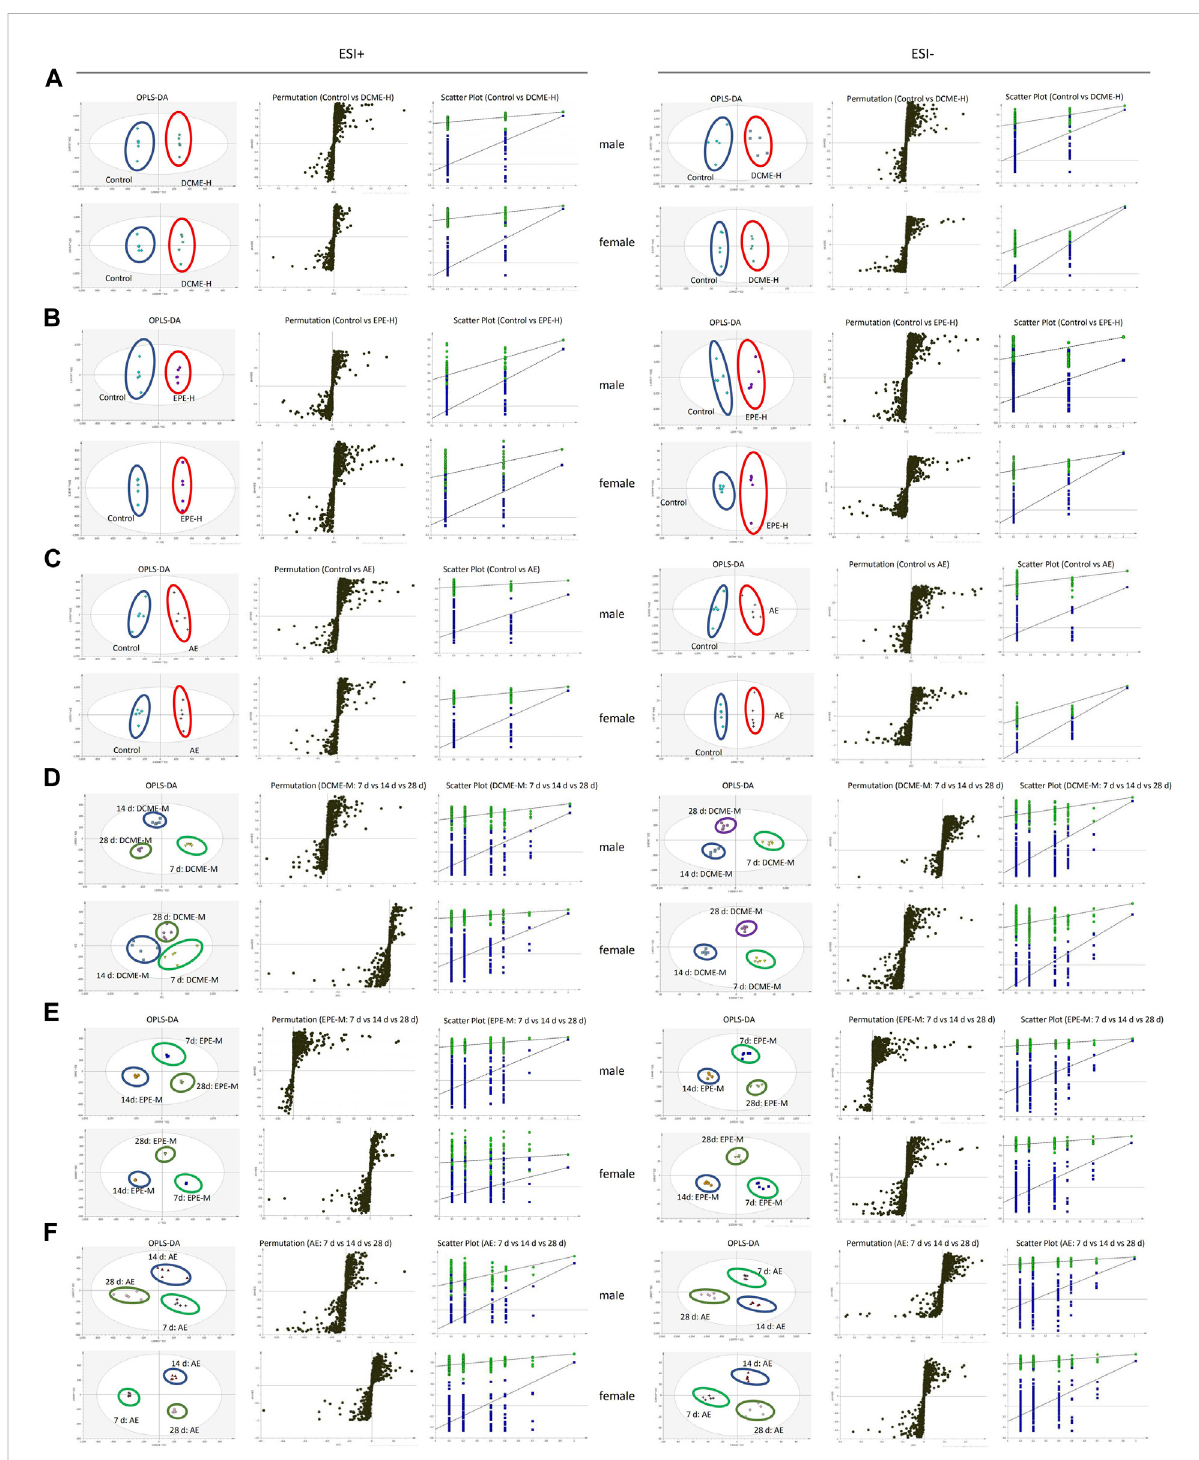
FIGURE 3 The OPLS-DA score plots, S-plots and 200-permutation test in the positive (ESI+) and negative (ESI-) modes. (A) Comparison of DCME-H and Controlgroups. (B) ComparisonofEPE-HandControlgroups. (C) ComparisonofAEandControlgroups. (D) ComparisonofDCME-Mgroupondays 7, 14 and 28. (E) Comparison of EPE-M group on day 7, 14 and 28. (F) Comparison of AE group on day 7, 14 and